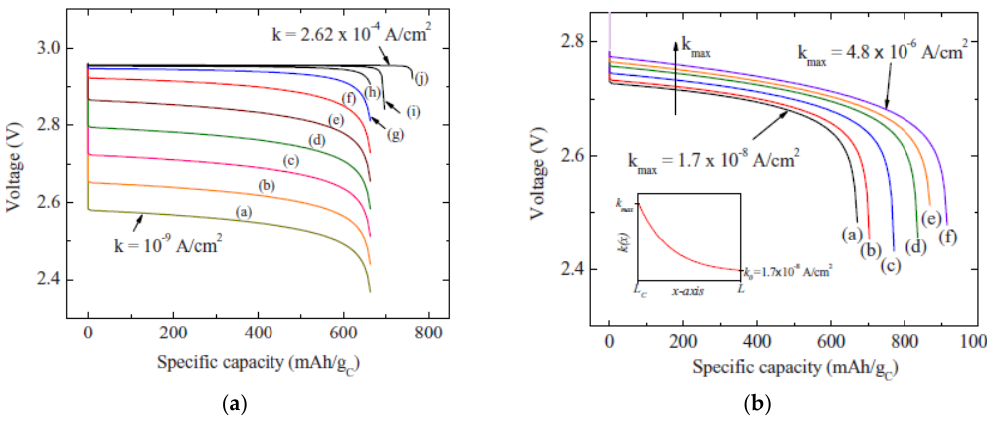
Figure 4. Cell voltage vs. specific capacity for different reaction rate coefficients: ( a ) uniformly and ( b ) non-uniformly distributed catalysts. Republished from Andrei et al. [16] with permission of the Electrochemical Society, conveyed through Copyright Clearance Center, Inc.